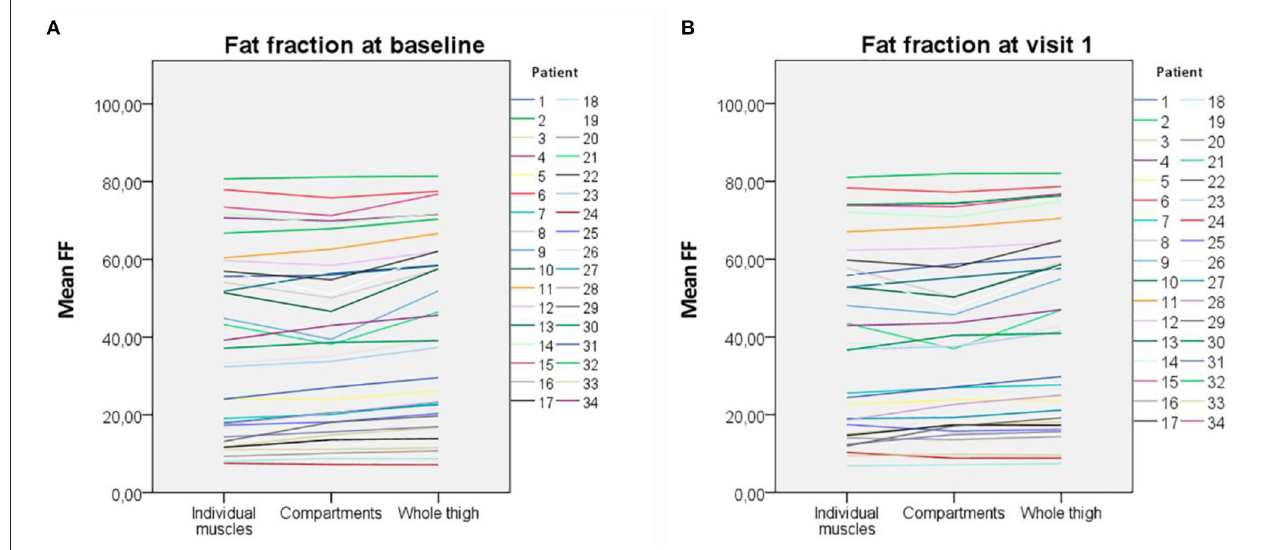
FIGURE 2 | Fat fraction obtained with the three methods of analysis for each patient. (A) At baseline. (B) At visit 1. The variability is higher in patients with middling fat replacement and lower in both patients with very high and very low fat replacement.